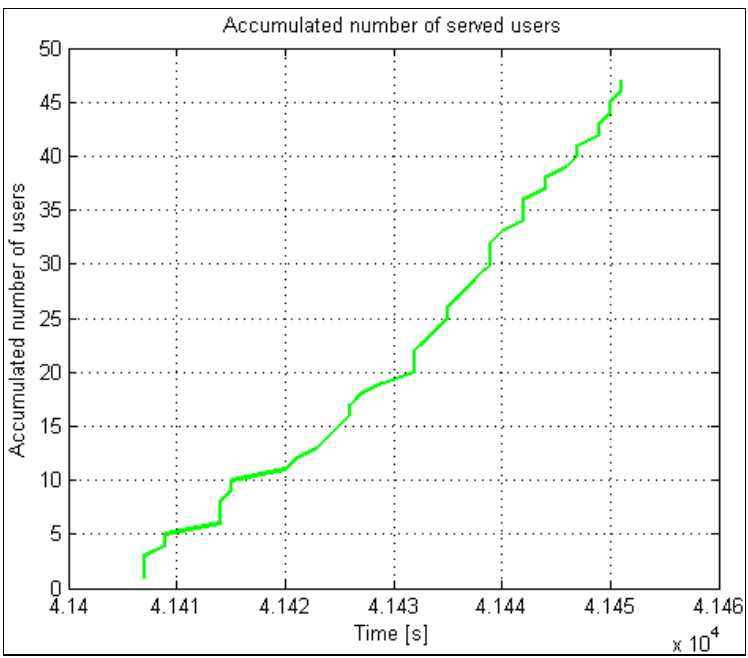
Figure 14. The total number of served users during the observation period. U = 47. Figure 15 clearly shows what happens in the EV charging system when user rejections start to appear (blue line).